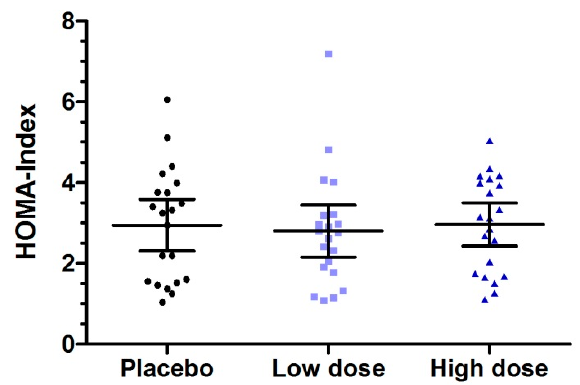
Figure 2. Distribution of homeostasis model assessment (HOMA) index at baseline at the testing days before intake of placebo or milk protein hydrolysate containing bioactive milk peptides in low and high doses. Data represent mean ±95% CI. Data represent mean ±95% CI. No statistical difference between baseline conditions.